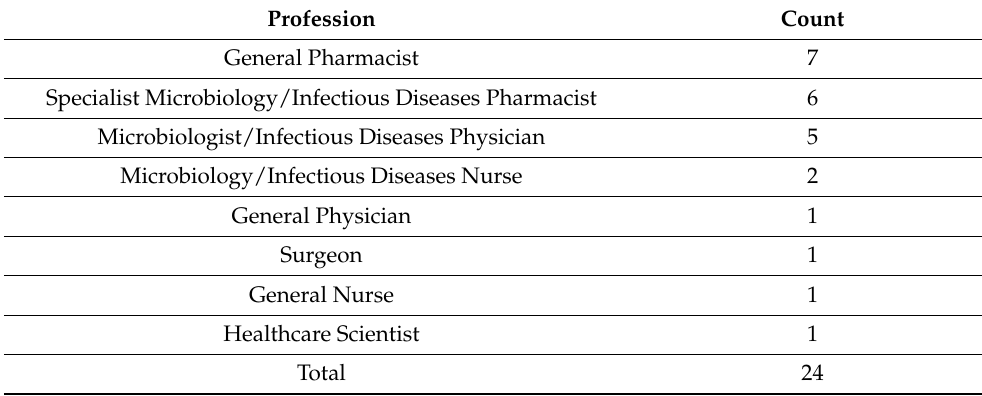
Table 1. Professions of respondents who participated in the Delphi (Step One) Pilot/1st round